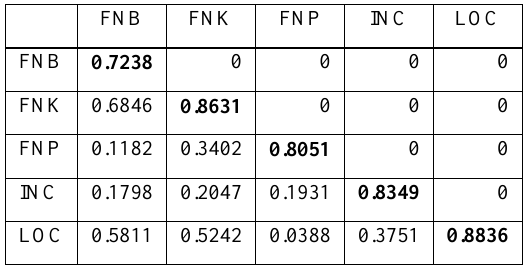
Table 6: The Correlation